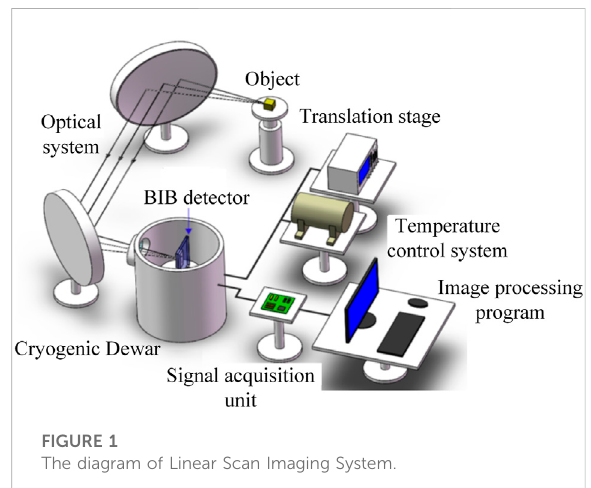
FIGURE 1 The diagram of Linear Scan Imaging